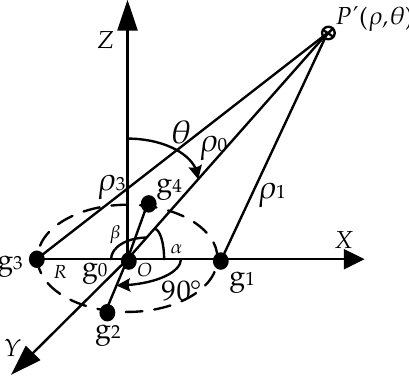
Figure 5. Schematic diagram of the sensor array. According to the geometric position relationship between the sensor array and the transmission line in the above figure, in △ P ’ Og1, using the cosine theorem, it is obtained that: